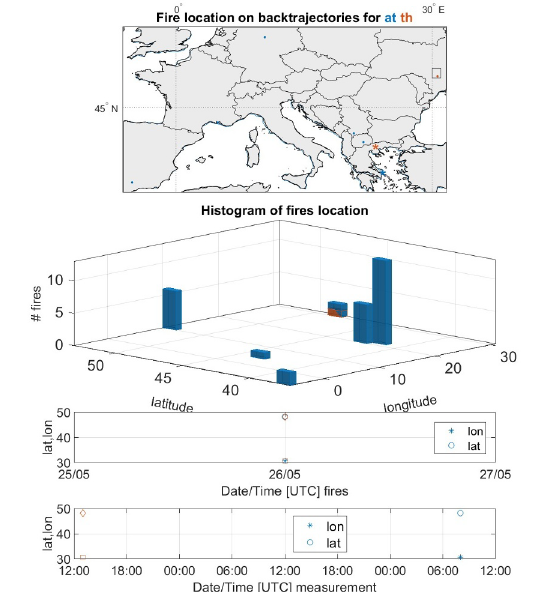
Fig. 1. Upper: location of the fires captured by “at” and “th” stations on 29 May - 2 June 2017. Square shows the common fire. Second: histogram of the number of fires’ detection. Third: common fire’ coordinates and time of fires’ observation. Bottom: fire’ coordinates versus lidar measurement time.